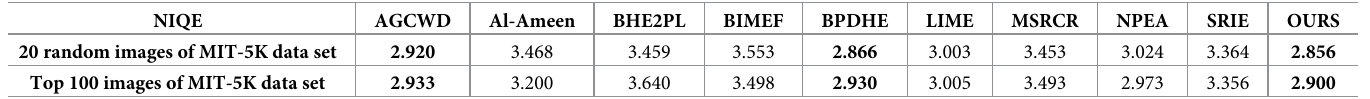
Table 18. Average NIQE values of three groups of